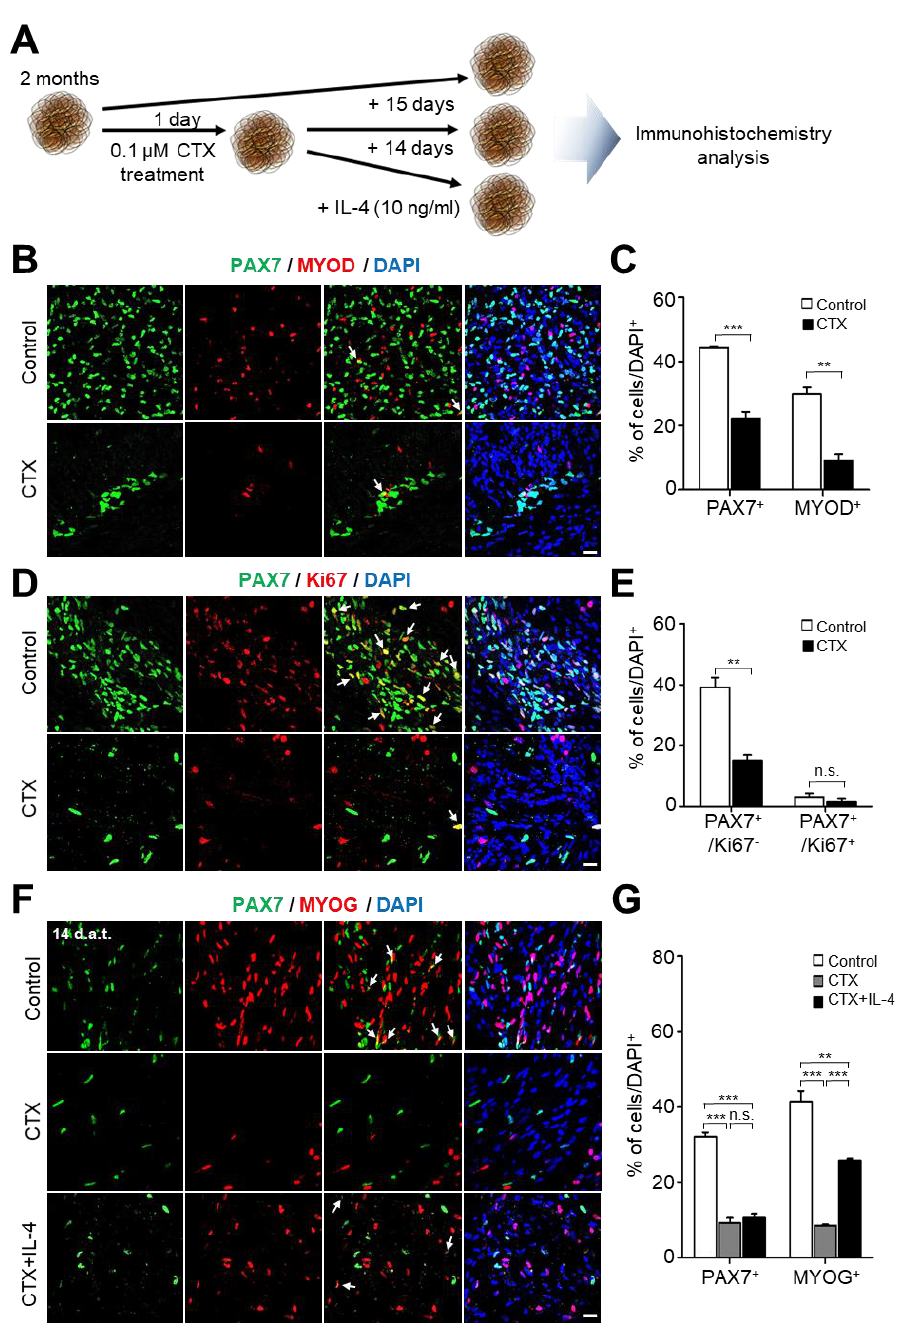
Figure 4. Characterization of mature hSkMOs. ( A ) Schematic diagrams for skeletal muscle regener- ation model using hSkMOs. ( B ) Cryosections of hSkMOs stained with specific antibodies against MYOD and PAX7. Scale bars, 20 μm. The quantifications are shown in ( C ); mean ± s.e.m., n = 3; unpaired t-test. Statistics: ** p <0.01, *** p <0.001. ( D ) Cryosections of day 50 hSkMOs stained with specific antibodies against Ki67 and PAX7. Scale bars, 20 μm. The quantifications are shown in ( E ); mean ± s.e.m., n = 3; unpaired t-test. Statistics: ** p <0.01; n.s., not significant. ( F ) Cryosection of hSkMOs stained with specific antibodies against MYOG and PAX7. Scale bar, 20 μm. The quantifi- cations are shown in ( G ); mean ± s.e.m., n = 3. Statistical analysis was performed using one-way ANOVA, followed by Tukey’s multiple comparison test. Statistics: ** p <0.01, *** p <0.001; n.s., not significant. White arrows indicate double-positive cells.